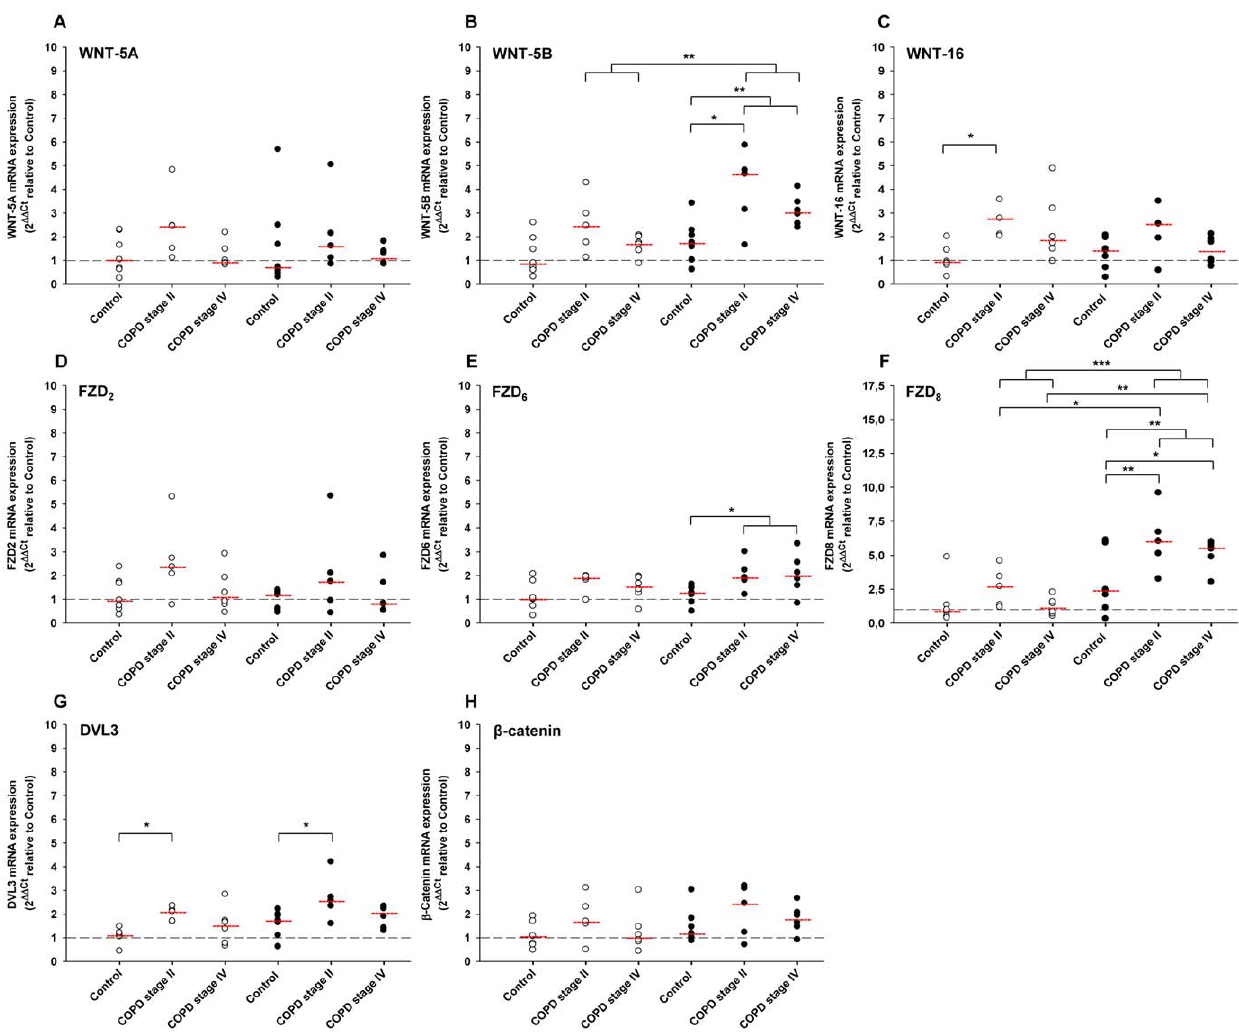
Figure 2. Differential WNT pathway gene expression in primary lung fibroblasts from individuals with and without COPD. Primary lung fibroblasts were isolated from individuals without (control) and with COPD (GOLD stage II and IV) as described in the materials en methods. qRT- PCR analysis of WNT-5A (A), WNT-5B (B), WNT-16 (C), FZD 2 (D), FZD 6 (E), FZD 8 (F), DVL3 (G) and b -catenin (H) mRNA of primary lung fibroblasts treated with or without TGF- b 1 (2 ng/ml) for 4 h. Expression of WNT pathway genes is plotted relative to the mean expression in untreated fibroblasts from controls. Data are derived from 7 controls and 11 COPD patients (5 GOLD stage II and 6 GOLD stage IV). mRNA expression was determined both at N ). Median of each group is indicated by -----. *p , 0.05, **p , 0.01, ***p , 0.001, baseline (open circles; # ) and after TGF- b stimulation (closed circles; two-tailed student’s t -test for unpaired observations or a One-way ANOVA followed by a Newman-Keuls multiple comparison test.